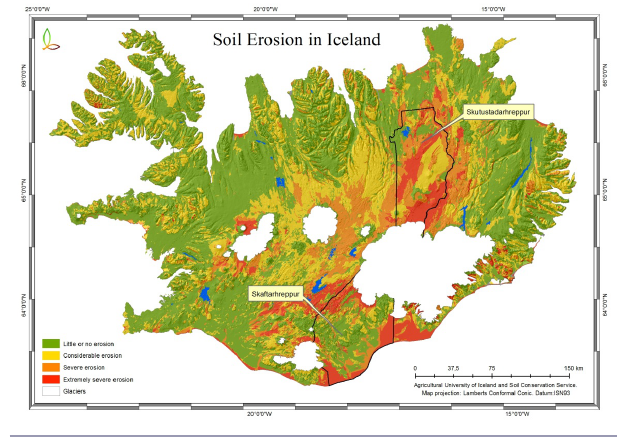
Fig. 1. General overview of soil erosion in Iceland and the geographical location of Skaftarhreppur and Skutustadahreppur. (The map is based on results from a national survey on soil erosion, published in 1997 (Arnalds et al.